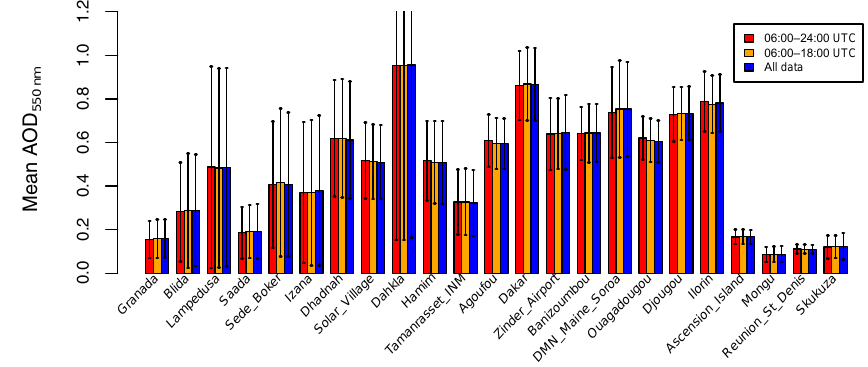
Figure 2. Comparison of methods to compute mean modeled AOD 550nm , for an example in January 2000: red bars include model output only for 06:00 to 24:00UTC; yellow bars for 06:00 to 18:00UTC; and blue bars for 24h. Whiskers are ± 1 standard deviation across the 6-hourly model values within each time